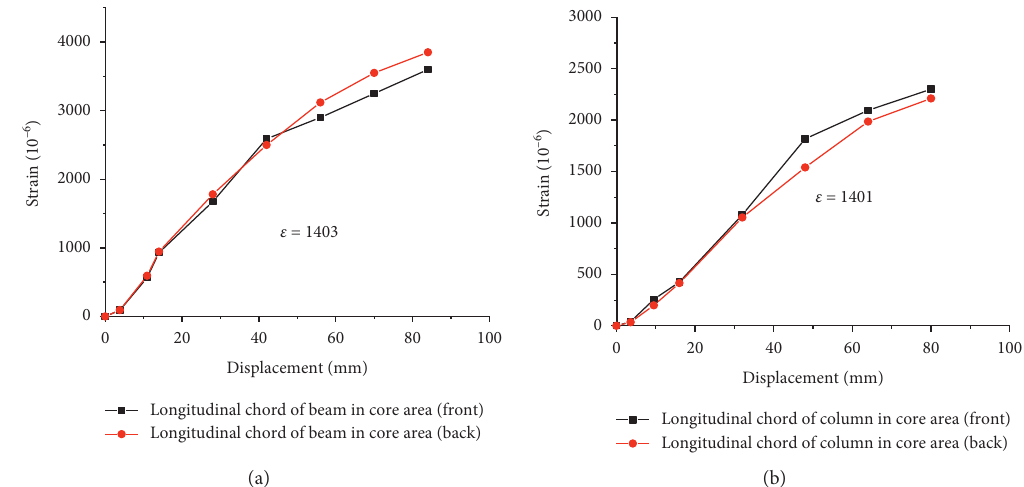
Figure 17: Strain of longitudinal reinforcement chord of beam-column in the core area: (a) longitudinal chord of beam in core area and (b) longitudinal chord of column in core area.